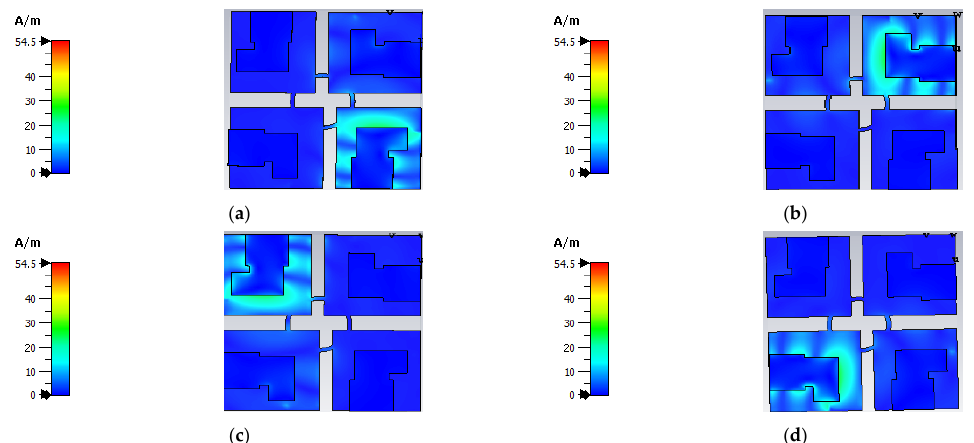
Figure 11. Surface current distribution when excitation is given to ( a ) port 1, ( b ) port 2, ( c ), port 3, and ( d ) port 4. The 3D radiation pattern is plotted as depicted in Figure 12 for element 1 by termi- nating all the ports with a matched load. It shows that the antenna provides gain of 8.48 dBi, 9.49 dBi, and 10.2 dBi at 26 GHz, 30 GHz, and 35 GHz, respectively.